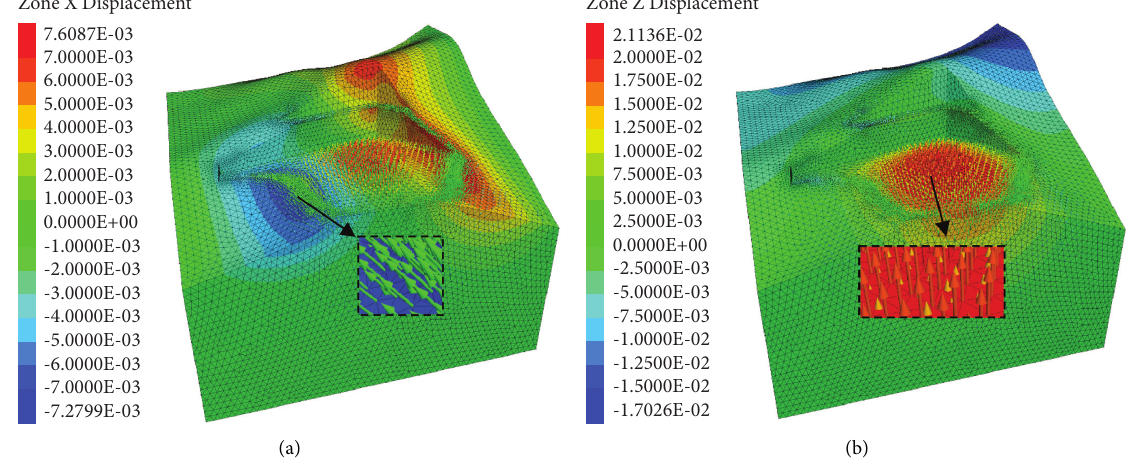
Figure 14: Strain nephogram after forth excavation. (a) X -direction strain nephogram and (b) Z -direction strain nephogram.